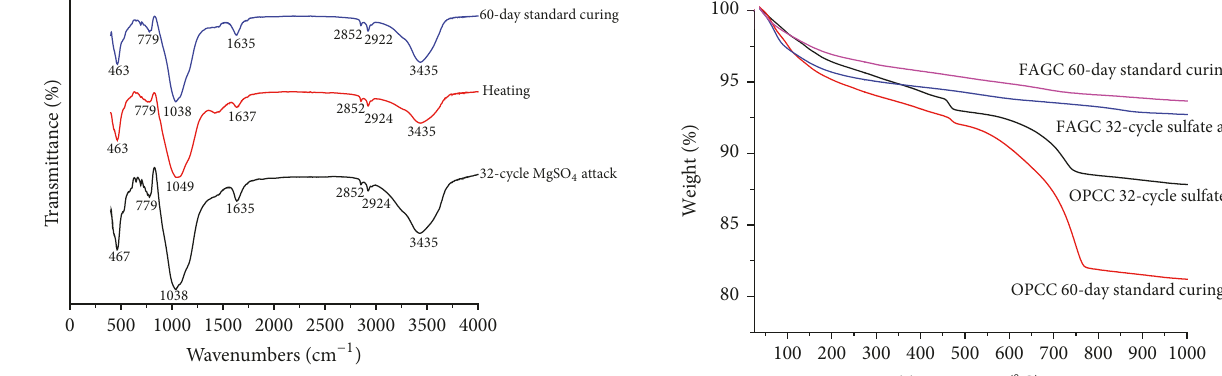
Figure 10: FTIR of FAGC in the 60-day standard curing condition, heating condition, and 32-cycle MgSO 4 attack environment, respec- tively.